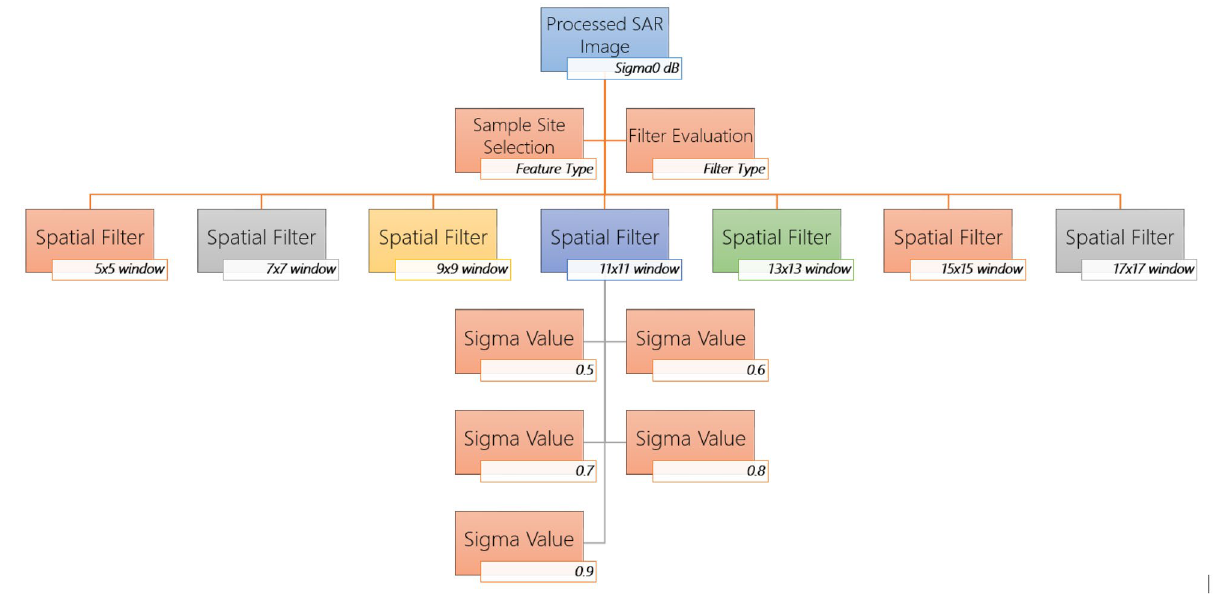
Figure 3. A conceptual framework for simulation and evaluation of filters